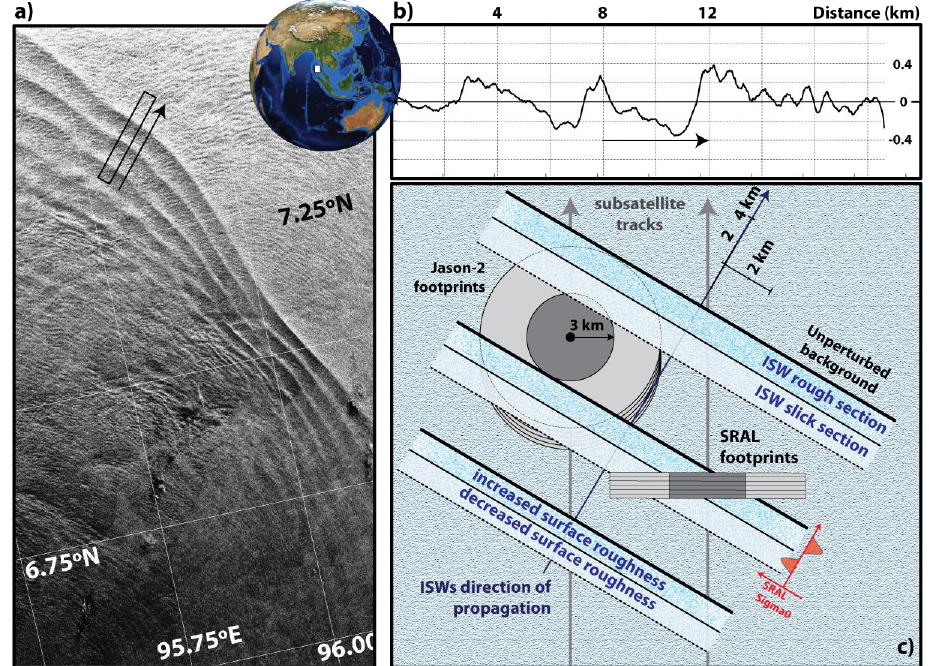
Figure 1. ( a ) Subset of an Envisat-ASAR (Advanced Synthetic Aperture Radar) image acquired in image precision mode dated 10 May 2005 at 03:29 UTC. The image shows a typical internal solitary wave (ISW) packet propagating northeast in the Andaman Sea (see inset in top-right corner for location). ( b ) ISW relative intensity retrieved from the black rectangle in the panel ( a ). ( c ) Schematic representation of ISW sea surface roughness patterns alongside typical altimetry footprints for Jason-2 and the synthetic aperture radar altimeter (SRAL). See text for more details.